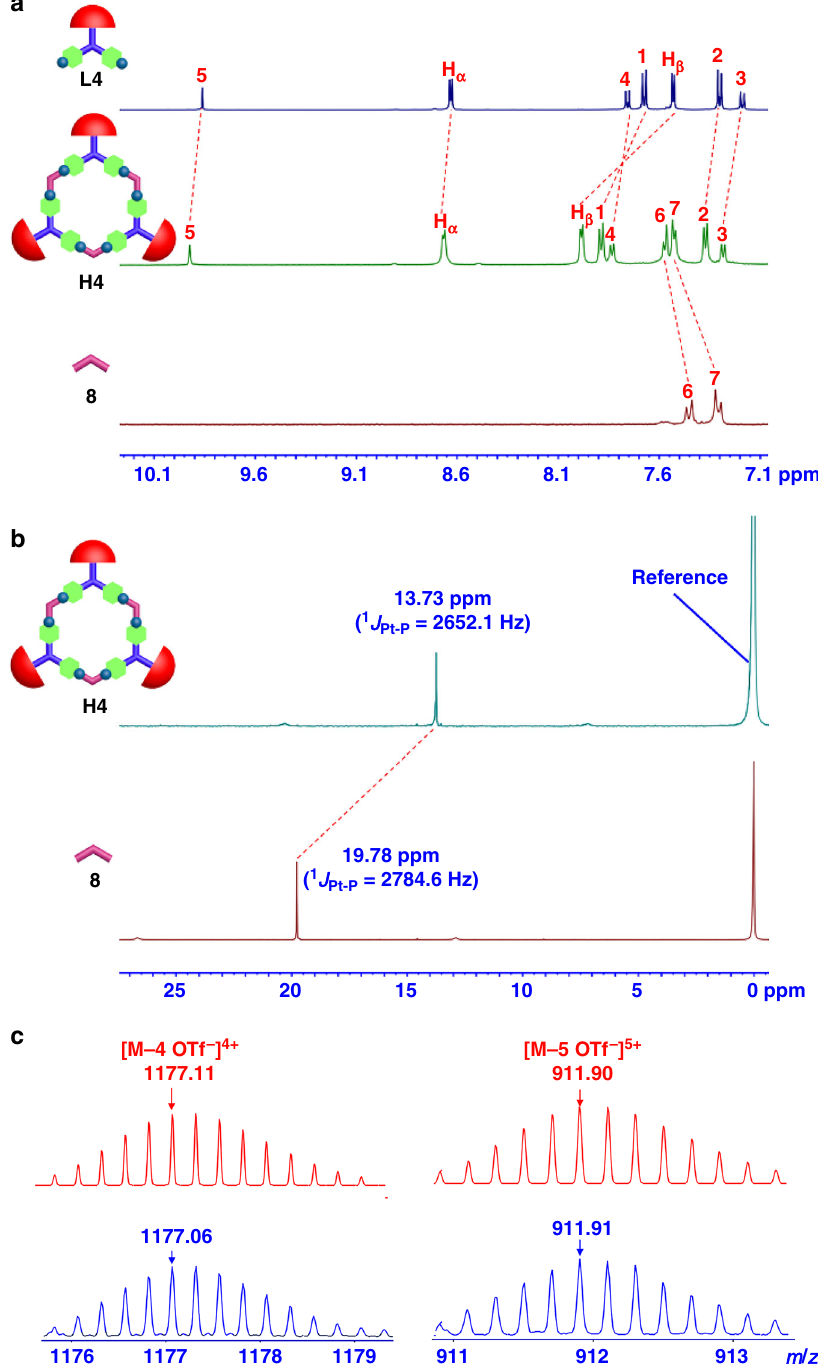
Fig. 2 NMR spectra and ESI-TOF-MS spectra of L4 and H4 . a Partial 1 H NMR spectra (500 MHz, in CD 2 Cl 2 ) of ligand L4 (top), 120° dipyridine donor 8 (bottom), and metallacycle H4 (middle). b 31 P NMR spectra (202 MHz, in CD 2 Cl 2 ) of metallacycle H4 (top) and 120° dipyridine donor 8 (bottom). c Theoretical (top) and experimental (bottom) ESI-TOF-MS spectra of metallacycle